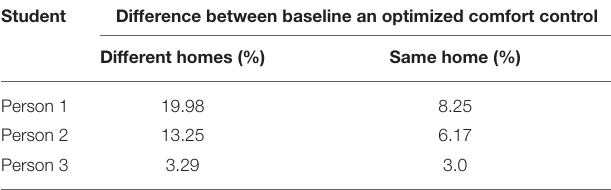
TABLE 9 | Comfort improvement using the proposed comfort control compared to baseline.